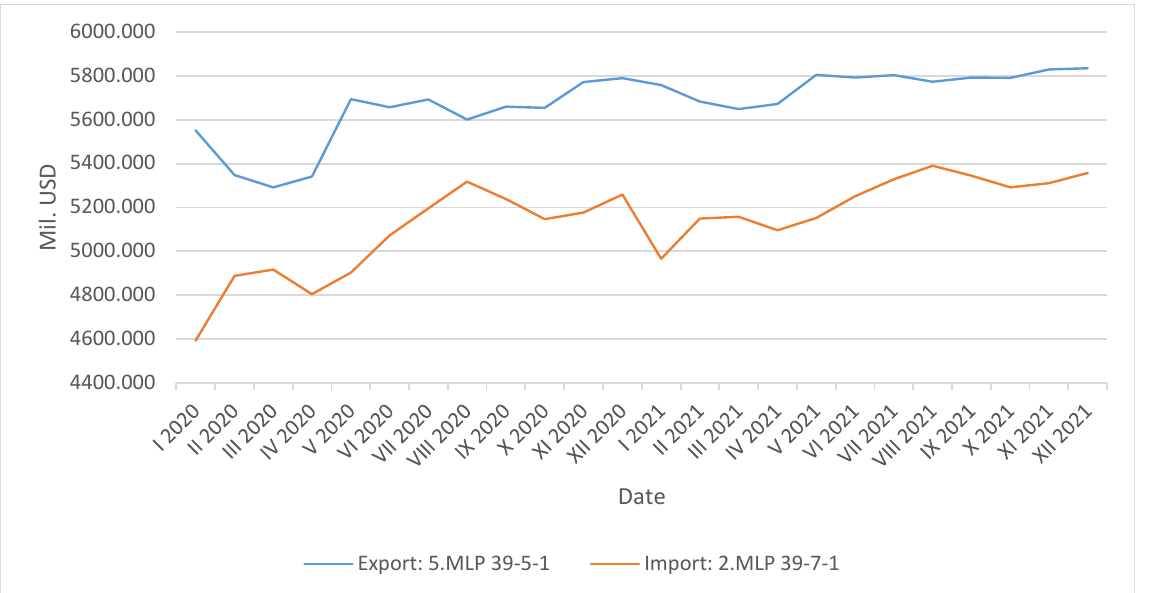
Figure 6. Development of mutual trade of RF and PRC between January 2020 and December 2021 (Source: Author).